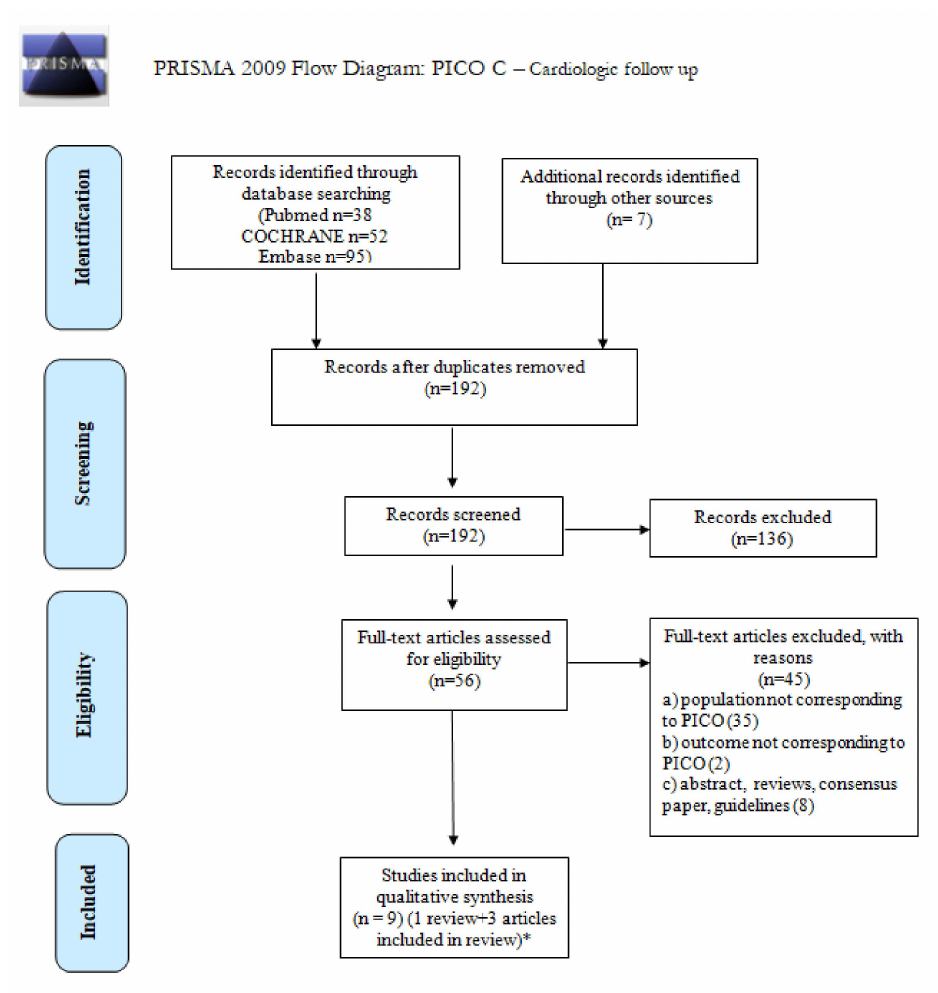
Figure 3. PRISMA 2009 Flow diagram for PICO C: cardiologic follow up. * Of 11 included studies, 3 studies [47,49,50] were included in Nolan’s systematic review